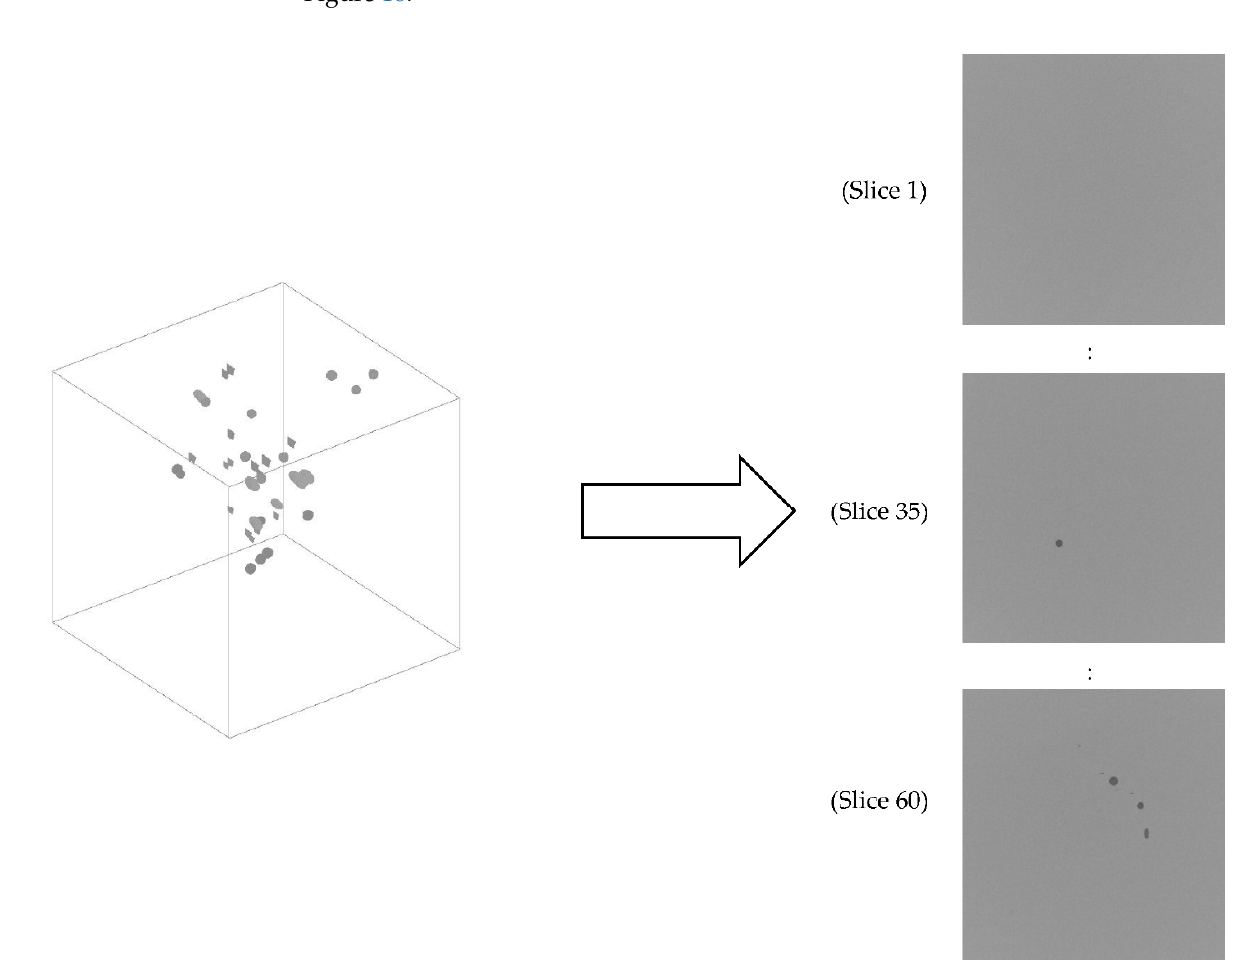
Figure 16. Illustrative example of the first version of artificial porosity images.